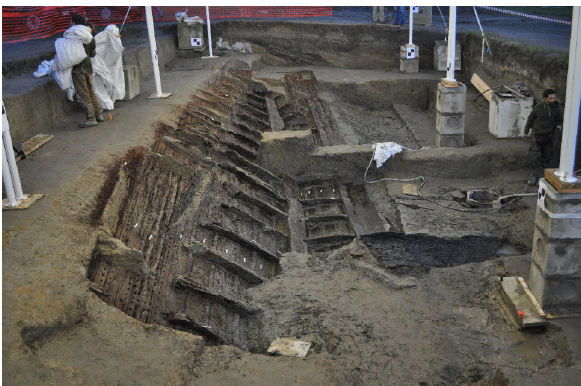
Figure 1. The archaeological site at the end of the excavation in 2014.